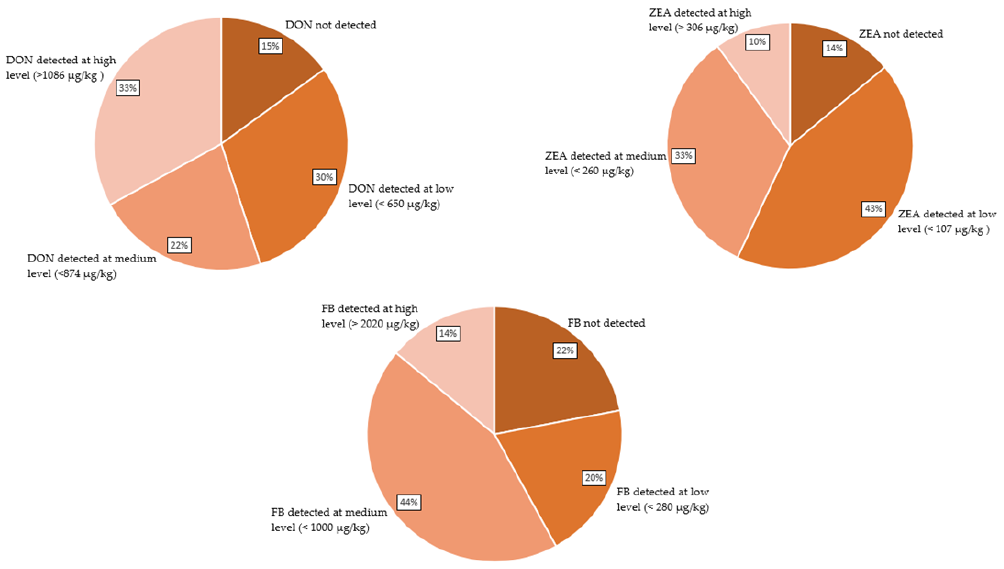
Figure 1. Distribution of Fusarium mycotoxins in silage. Adapted from tables in Gallo et al. [6]. Silage, which is the main constituent of cattle ration in several parts of the world, can present high levels of contamination if it is not produced according to good silage practices. This represents a novel area of research about mycotoxicosis in livestock. Gallo et al. [101] characterized sixty-four corn silages for chemicals, bacterial communities, and concentrations of several fungal metabolites. Silages were grouped in five clusters based on the detected mycotoxins, and they were characterized for their contamination by (1) low levels of Aspergillus and Penicillium mycotoxins; (2) low levels of Fusarium mycotoxins; (3) high levels of Aspergillus mycotoxins; (4) high levels of non-regulated Fusarium mycotoxins; and (5) high levels of FBs and their metabolites. High occurrences were observed for FBs, but the levels were still close to the recommended levels. 6. Preventing Field Contamination with Fusarium Mycotoxins To minimize mycotoxin contamination in animal diets, it is important to adopt the good agriculture practise followed by the good manufacturing practises during the handling, storage, processing, and distribution of the raw material. Following the HACCP system (hazard analysis critical control point) will be useful to identify and control hazards in the production and processing system. It is necessary to consider the climate conditions of the specific years and the environment where the specific culture is grown. Wegulo [102] reported that it is useful to cultivate crops resistant to the infection of this fungi to inhibit the growth of the fungi and to use specific agro-technical methods such as sowing at the correct time (which influences the harvesting time and the presence of the fungi in the environment), adopting the rotation of the culture, ploughing the residue of the culture in the soil, not exceeding with nitrogen fertilization, using fungicides on the crop if necessary, and avoiding damage to the kernel. Zorn et al. [103] compared the effectiveness and economic impact of ploughing, crop rotation, and choice of variety in decreasing DON contamination in the field. These authors observed that ploughing decreased DON contamination in the feed by circa 32%, crop rotation (maize–no maize) decreased the contamination by 7%, and the choice of wheat variety decreased contamination by 36%, but ploughing was preferred because when selecting a variety, its nutrient composition should also be considered. Excess precipitation during anthesis (flowering) makes conditions favourable for dissemination and infection by Fusarium spp.; thus, irrigation during anthesis and during the ripening of the crops, specifically wheat, barley, and rye, should be avoided [104]. The